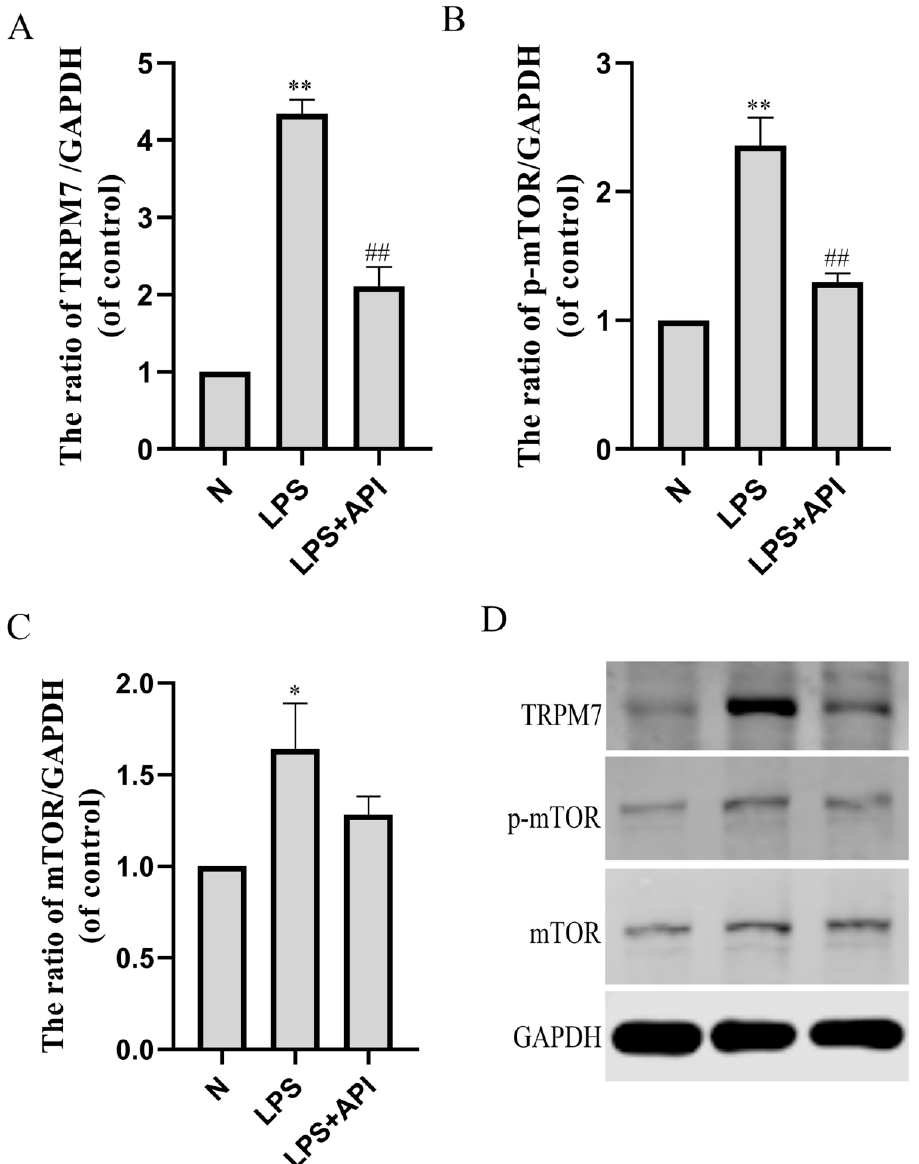
Figure 7. The effects of apigenin on the TRPM7, p-mTOR, and mTOR levels of macrophages in the macrophage–chondrocyte coculture system. ( A ) TRPM7 protein level; ( B ) p-mTOR protein level; ( C ) mTOR protein level; ( D ) Representative Western blotting images of TRPM7, p-mTOR, and mTOR. Data are the mean ± SD of the mean. * p < 0.05 versus normal group (N); ** p < 0.01 versus normal group (N); ## p < 0.01 versus LPS group.